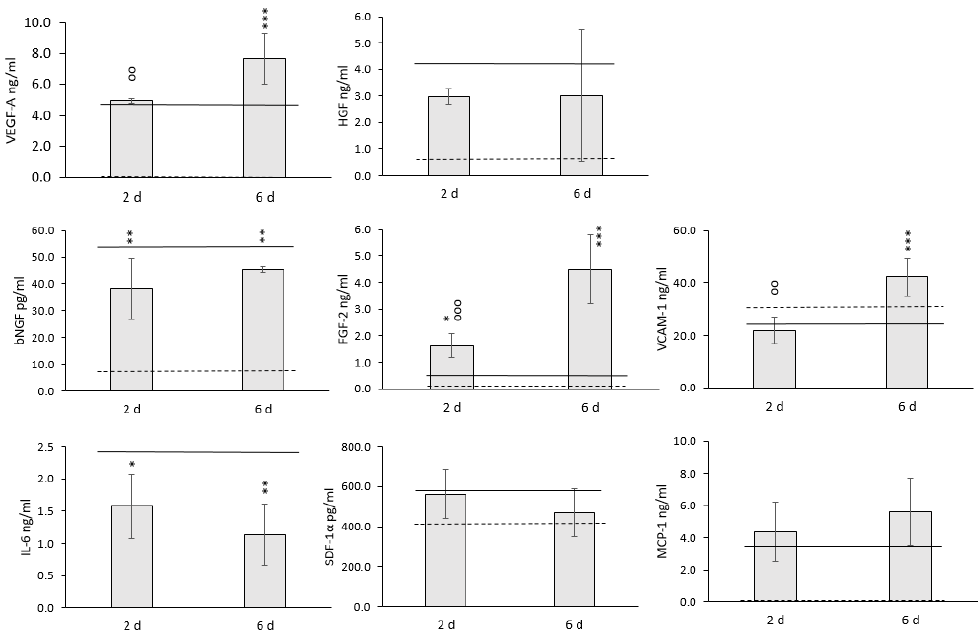
Figure 4. The secretion profile of 3D cultured WJ-MSCs after hypothermic storage ( n = 6). The data are presented as Mean ± SD. Solid line — non-stored cells, dashed line — background control (the medium without cells). *, **, *** — the data are significantly different compared to the non-stored cells (*** — p < 0.001; ** — p < 0.01; * — p < 0.05); °°, °°° — the data are significantly different between the 2d group and the 6d group (°°° — p < 0.001; °° — p < 0.01).